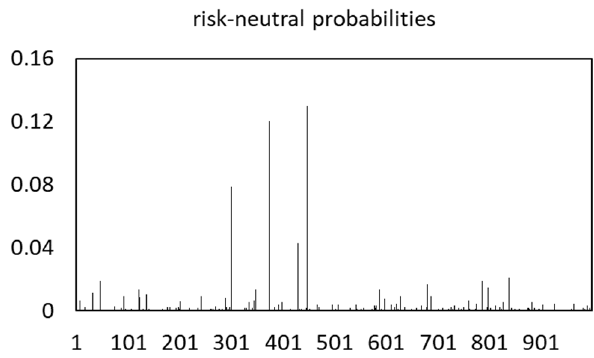
Figure 8. Risk-neutral probabilities calculated from simulated values and market price constraints.